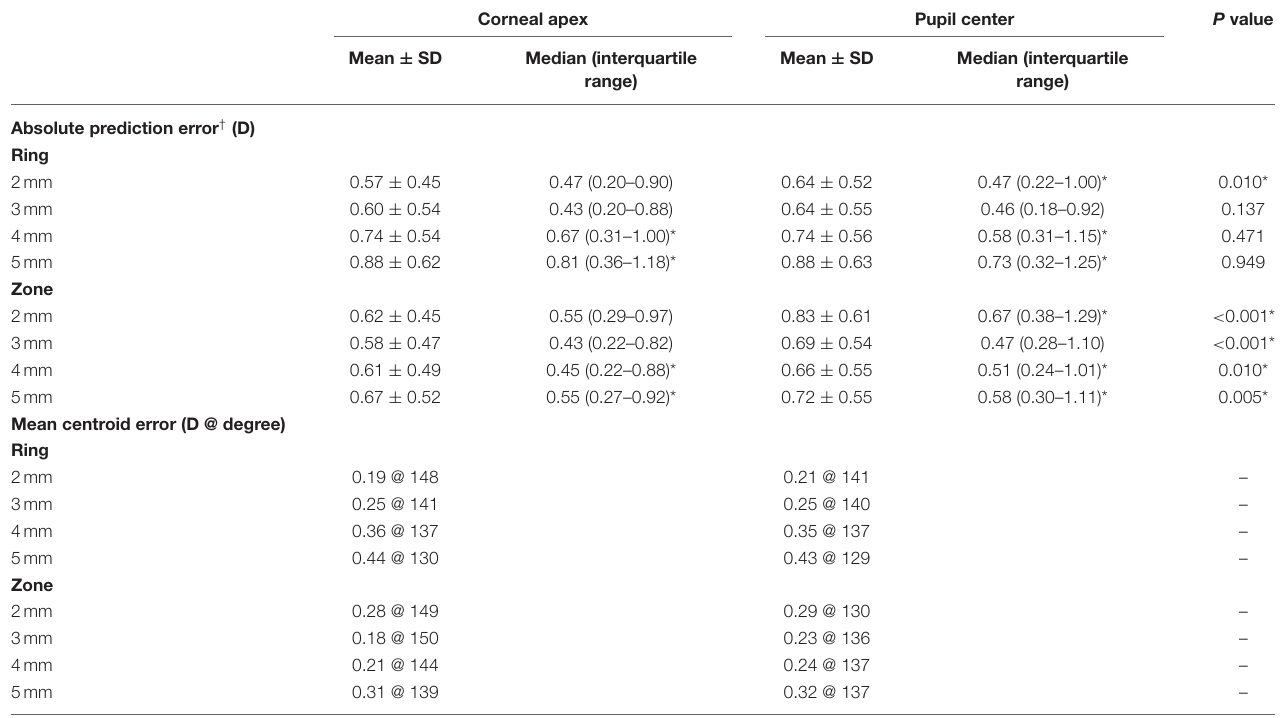
TABLE 2 | Prediction errors of corneal astigmatism based on the ring or zone mode either centered on the corneal apex or pupil center. Corneal